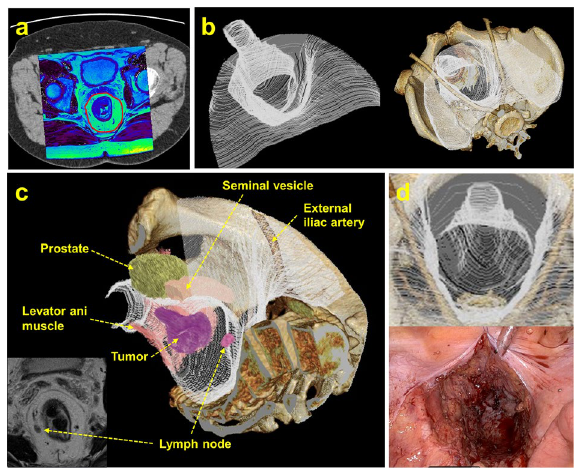
Figure 1. Three-dimensional (3D) visualization of the total mesorectal excision (TME) dissection plane. ( a ) A T2-weighted magnetic resonance image was superimposed on the contrast-enhanced computed tomography image. The line of TME dissection was manually traced (red line). ( b ) Created 3D images of the TME dissection plane. ( c ) A 3D image of the TME dissection plane in a male patient. The primary tumor, swollen lymph node, pelvic bone, external iliac artery, levator ani muscle, prostate, and seminal vesicle are also shown. ( d ) Comparison of the 3D TME dissection plane image and intraoperative image of the pelvic cavity after TME and resection of the rectum in the same